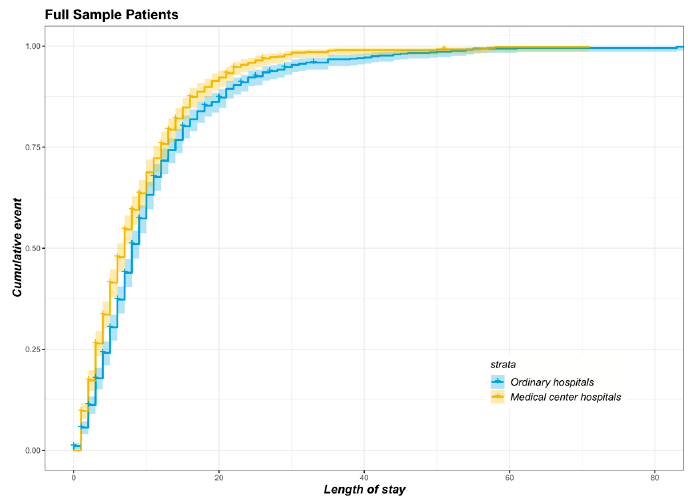
Figure 4. Kaplan–Meier survival curves of matched full sample patients transported by EMS in two groups.